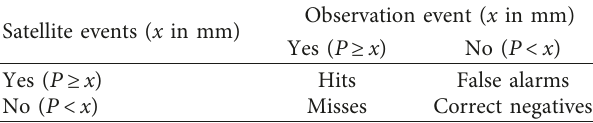
Table 4: Contingency table for categorical indices